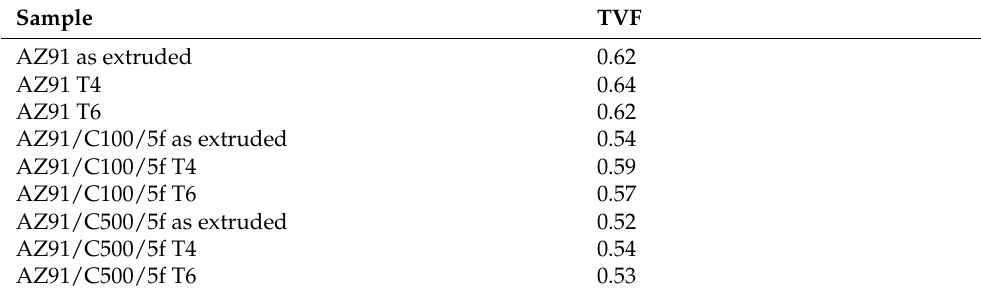
Table 5. TVF of the matrix at failure